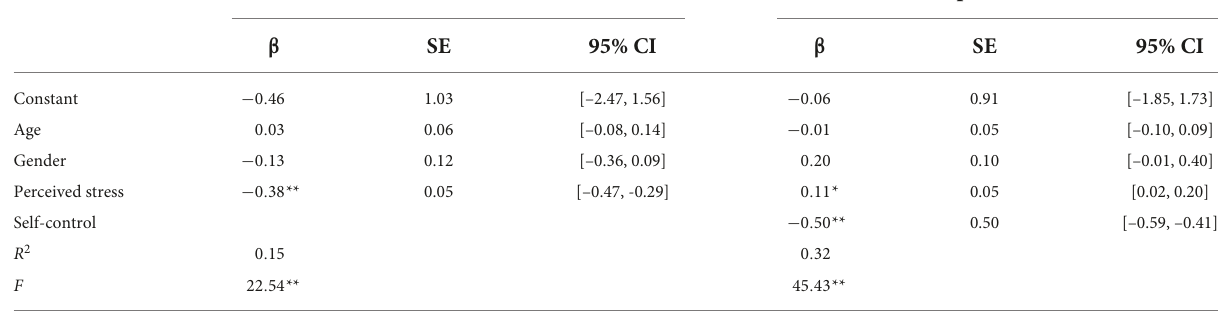
TABLE 2 Summary table of mediation effect analysis.